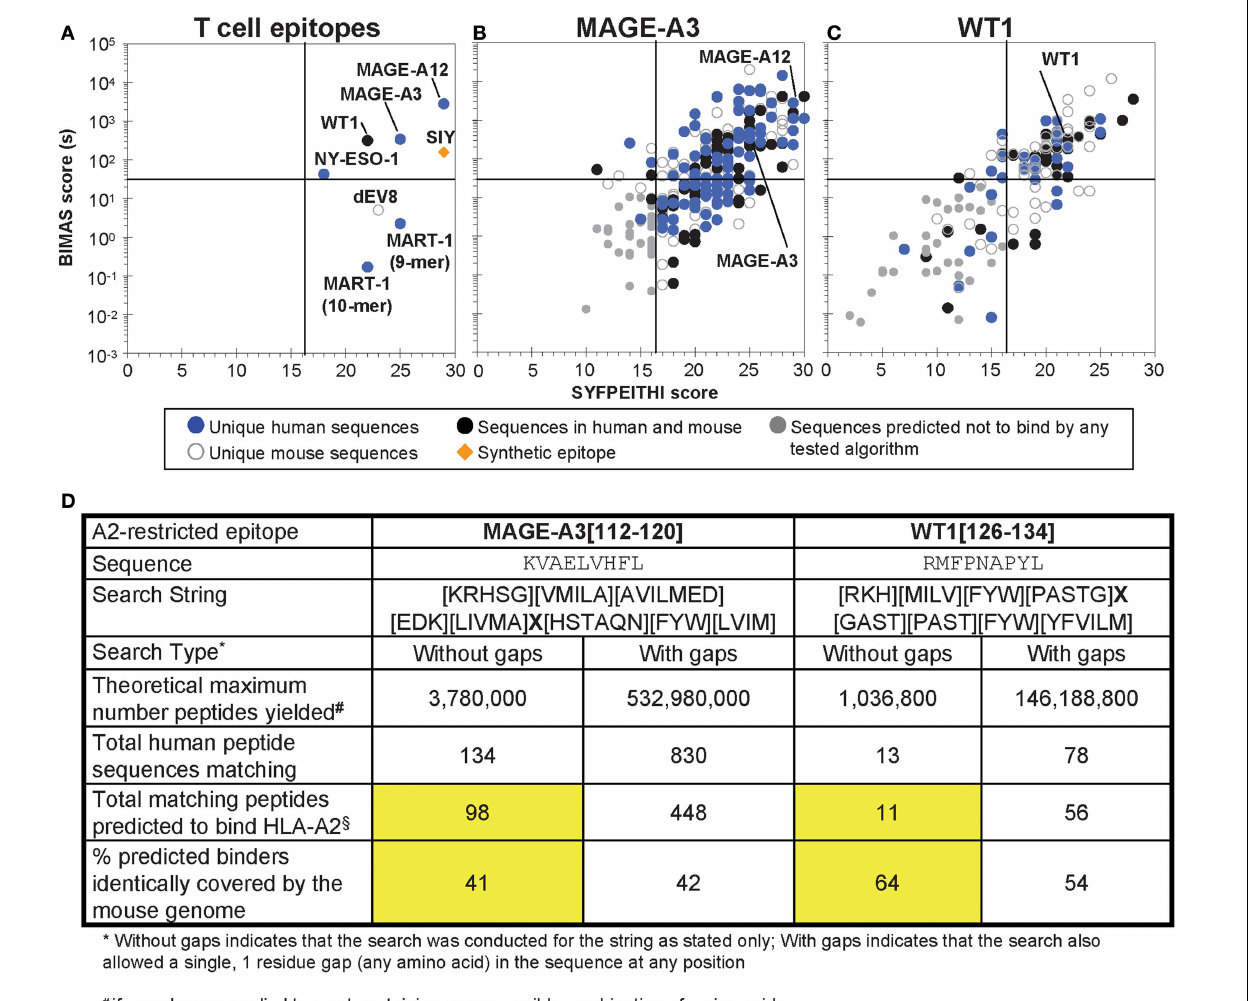
FIGURE 3 |Analysis of selected tumor epitopes for homologous sequences in the human and mouse proteomes . (A) MHC-binding prediction scores for a set of characterizedT cell epitopes, including six HLA-A2-restricted human tumor-associated epitopes. (B) MHC-binding predictions for peptides identified in a MAGE-A3 [112–120] homology scan (no gaps) of the human and mouse proteomes. (C) MHC-binding predictions for peptides identified in aWT1 [126–134] homology scan of the human and mouse proteomes (including an allowed, single-amino acid gap).